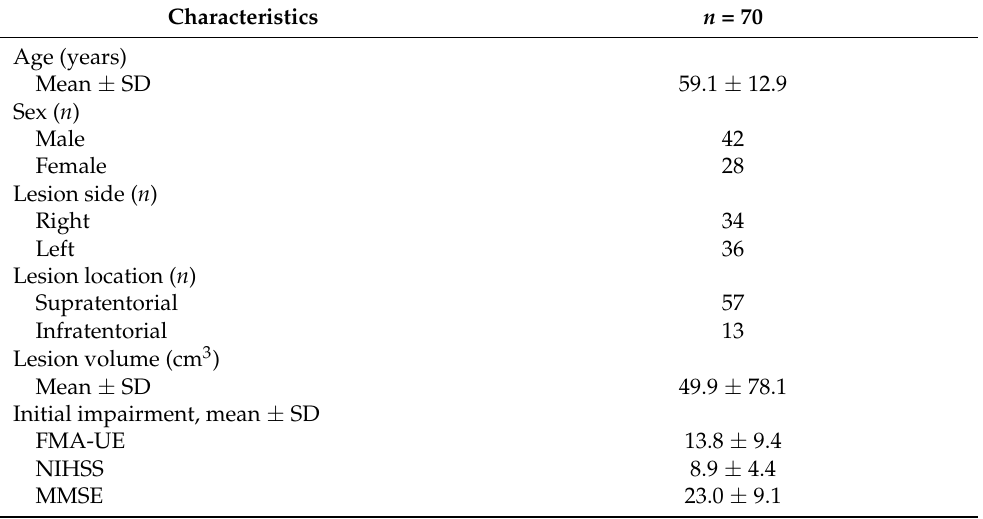
Table 1. Demographic and clinical characteristics of